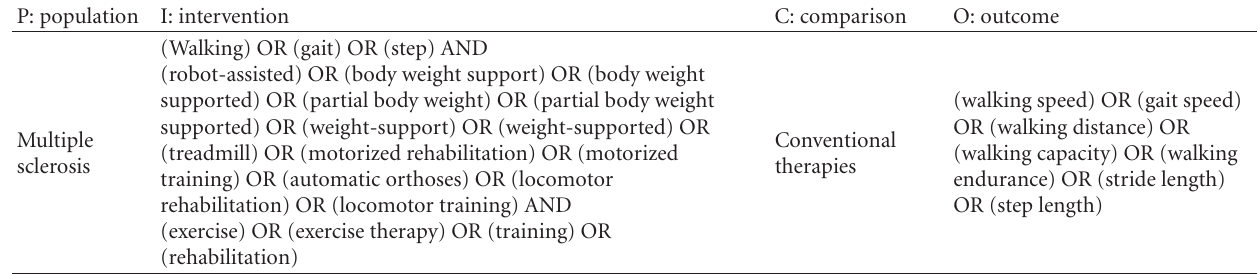
Table 1: Key words and MeSH terms and their combinations that were used in the literature search. In the search keys: between the columns “AND” was used. The key words “Multiple Sclerosis”, “Gait”, “Walking”, “Exercise”, and “Exercise Therapy” were used as MeSH terms in the database